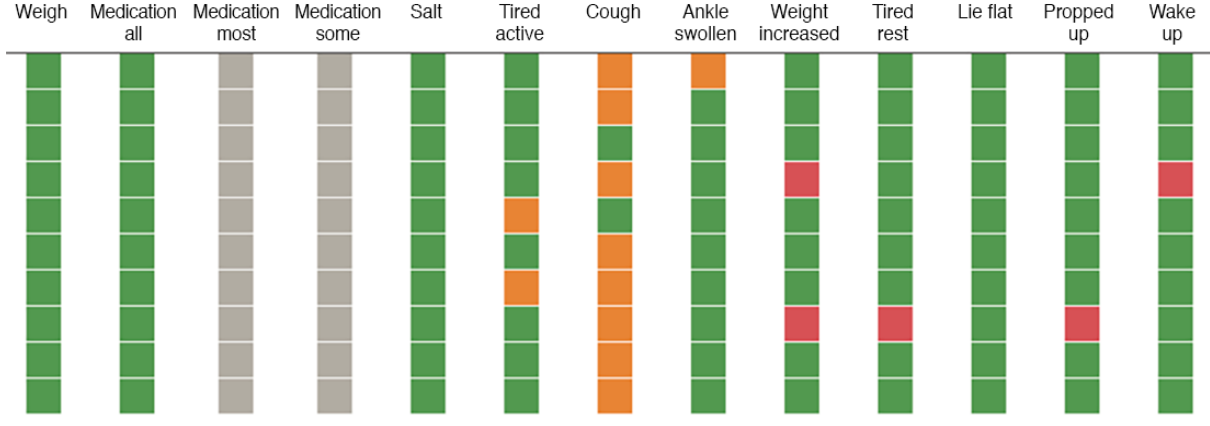
Figure 2. Example of color display used in the monitoring of patients, as it appears in the email sent to the study nurse. Green indicates that the patient either complied with the corresponding instruction (columns 1-5) or did not have the corresponding symptom (columns 6-13), orange indicates that the patient gave a positive answer to the corresponding mild heart failure (HF) symptom question, and red indicates that the patient gave a positive answer to the corresponding moderate or severe HF symptom question. Gray indicates skip logic, meaning these questions were not required based on the previous